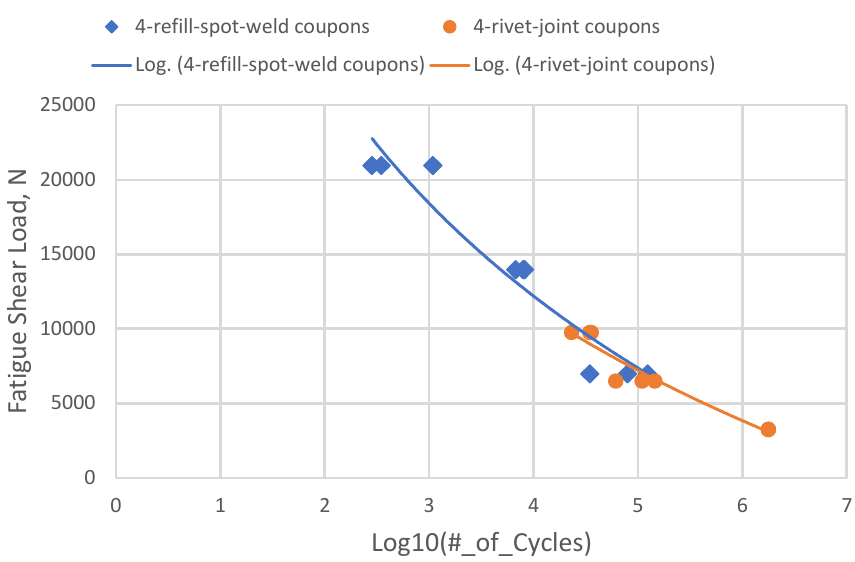
Figure 11. Fatigue test results: fatigue tests were carried out in accordance with NASM-1312-21.